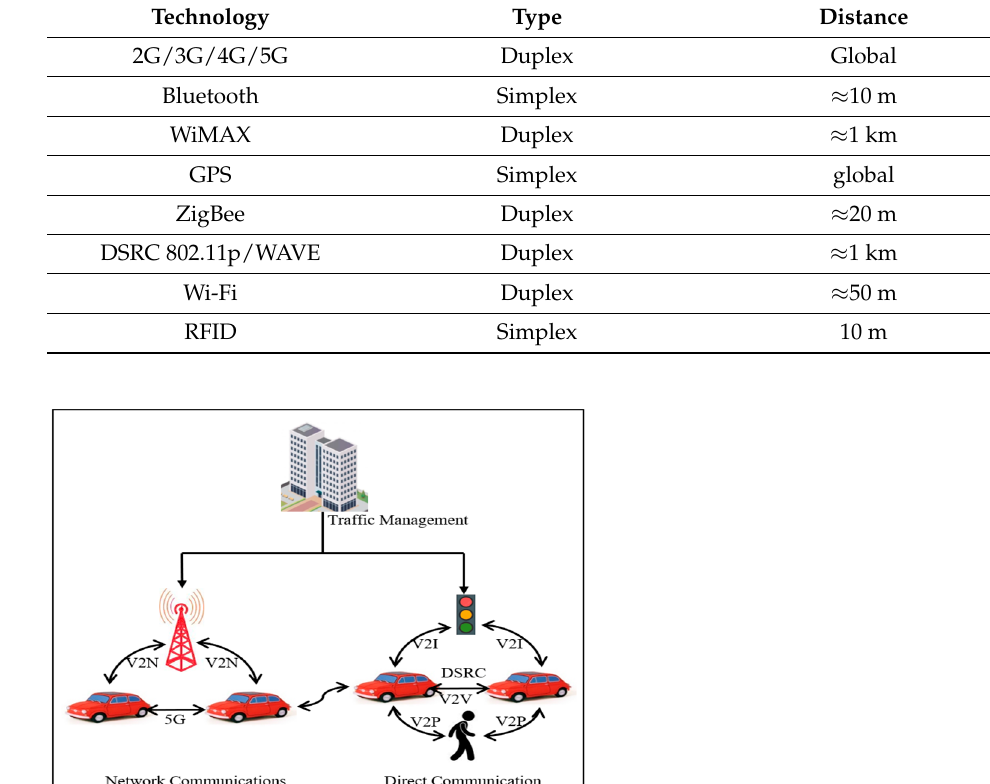
Table 1. Communication technologies in VANET [2].